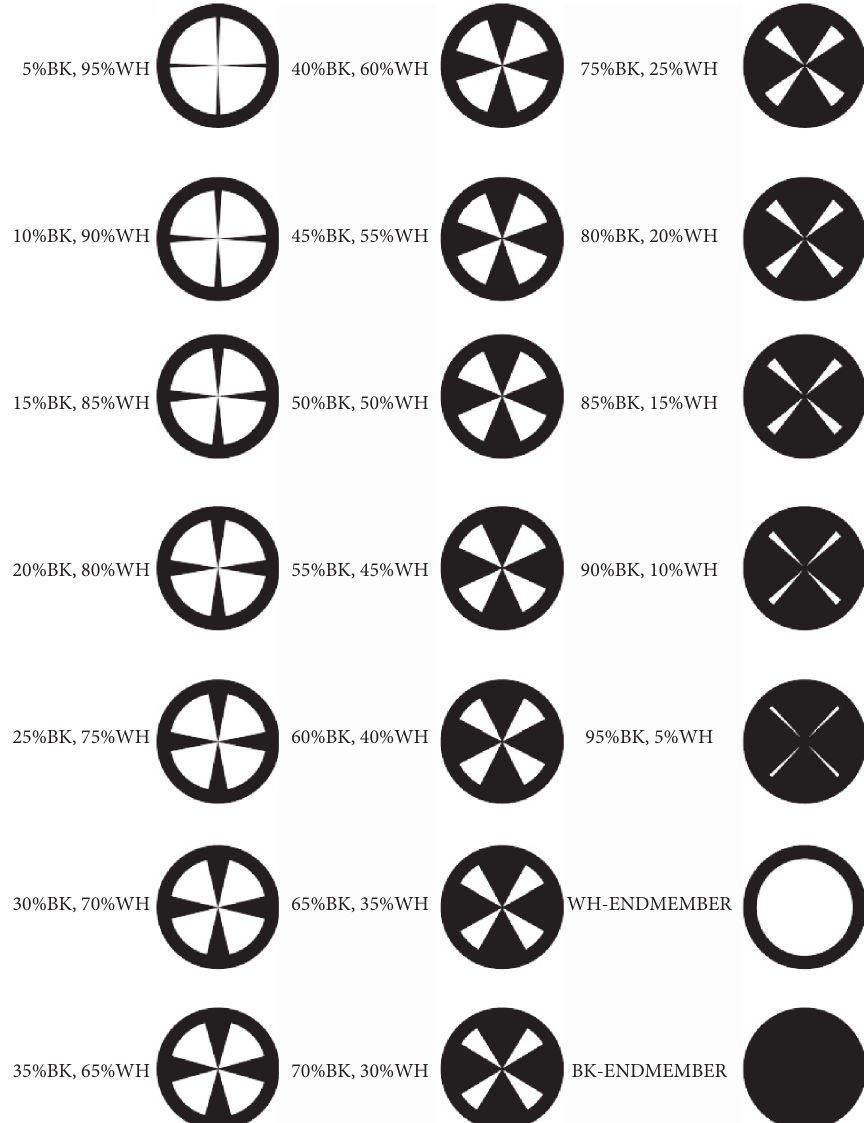
Figure 1: Sample design of mixed pixels.